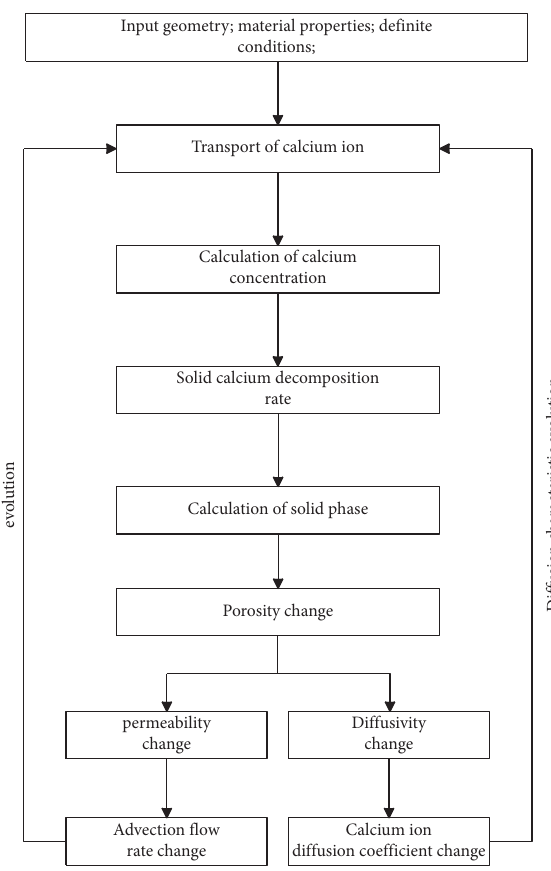
Figure 5: Overall scheme of the leaching